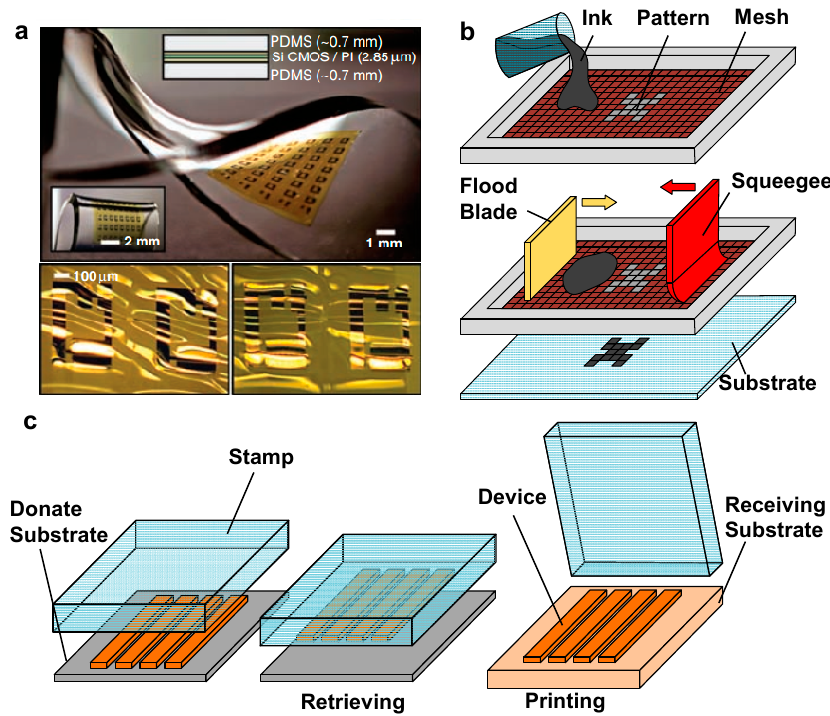
Figure 4. ( a ) Stretchable integrated circuits fabricated based on CMOS technology (Reprinted with permission from Ref. [26] Copyright 2008 American Association for the Advancement of Science); ( b )